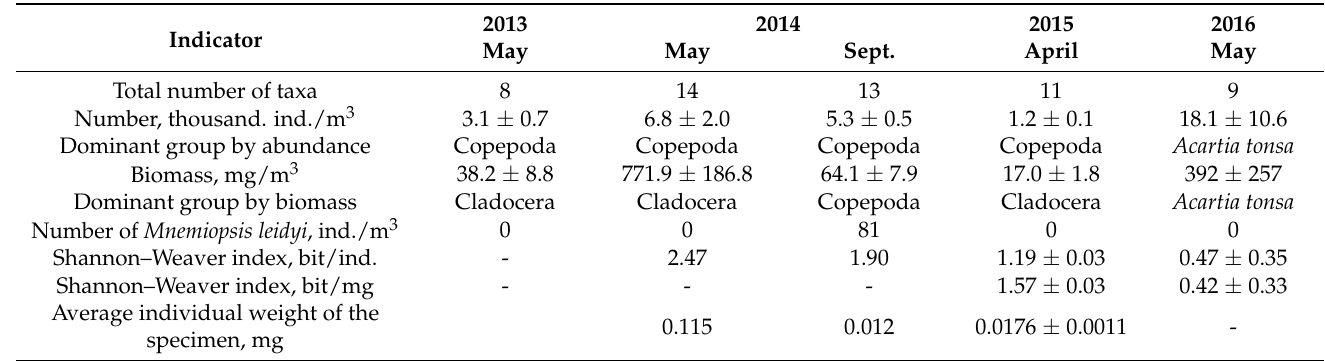
Table 10. Comparative characteristics of the zooplankton structure in the eastern section of the Middle Caspian.